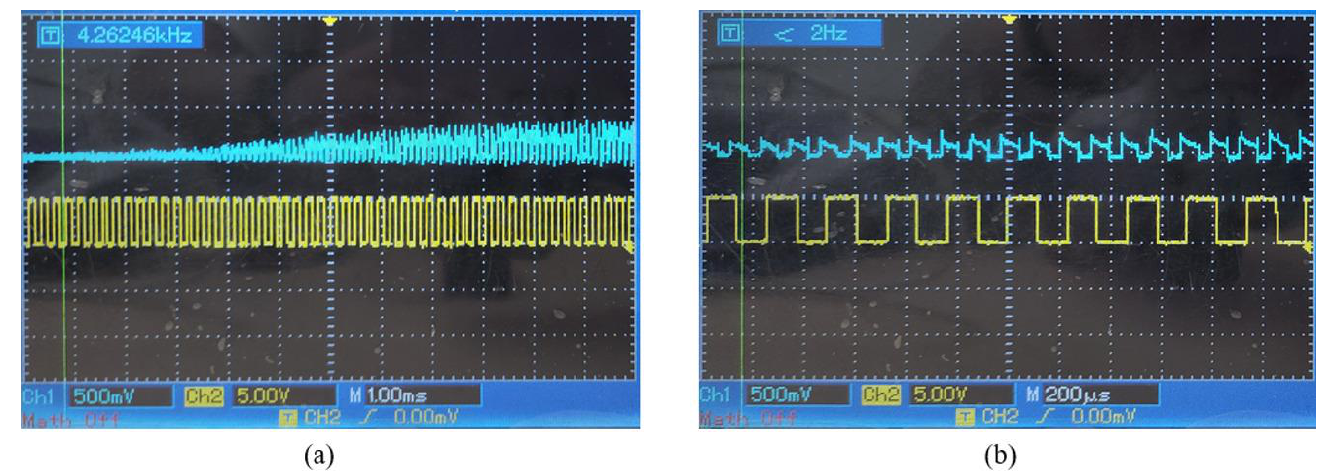
Figure 22. Signal envelope and GPIO flip image; ( a ) 1 ms scale waveform; ( b ) 200 us scale waveform.